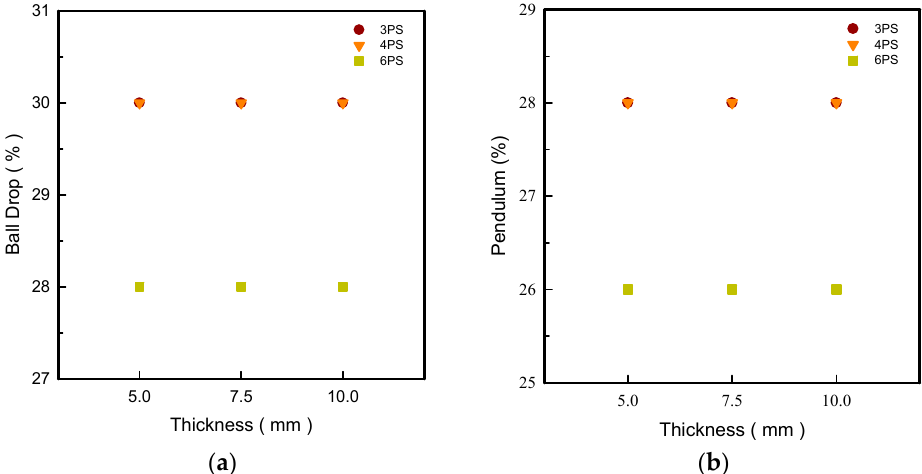
Figure 5. Ball drop ( a ) and pendulum ( b ) resilience of the LW 3DP 3-, 4-, and 6-PS outsole with various thicknesses.